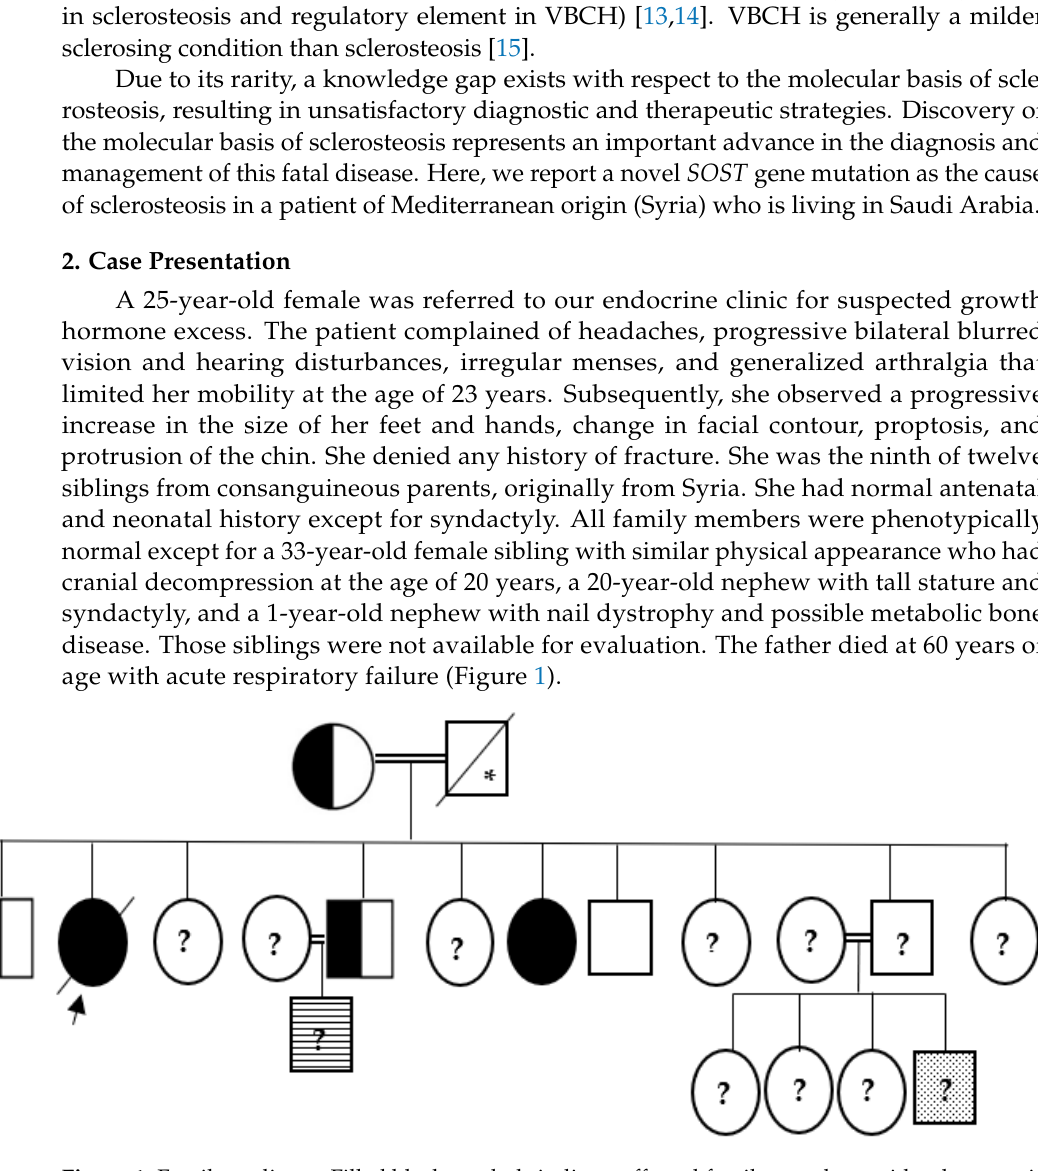
Figure 1. Family pedigree. Filled black symbols indicate affected family members with sclerosteosis (SOST ex.2a: c.387delG, p.Asp131ThrfsTer116) homozygote. Half-filled symbols indicate heterozygote for the mutation. The dotted symbol indicates having syndactyly and the lined one indicates nail dystrophy with query bone metabolic bone disease. The question mark symbols indicate unknown mutation status (not evaluated). The star symbol indicates inferred mutation carrier (heterozygote or homozygote). The proband is indicated with the arrow. The patient was tall with a height of 170.5 cm, weight of 105.4 kg, and body mass index (BMI) of 36.26 kg/m 2 . She had large facial contours, frontal bossing, prominent supraorbital ridges, proptosis of the eyes, prognathism, and misaligned teeth. Skeletal examination revealed a deformed left index finger with soft tissue syndactyly between the